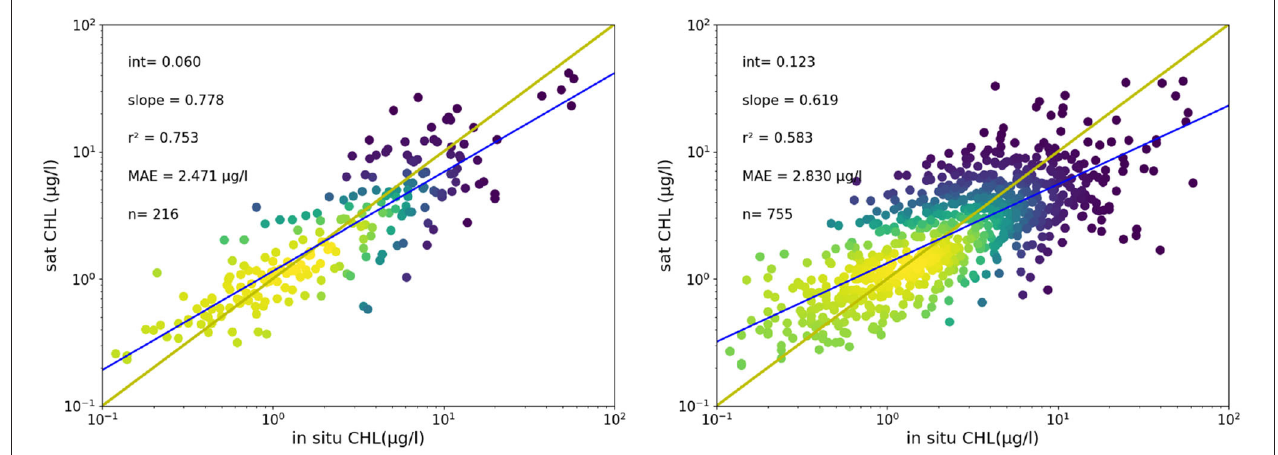
FIGURE 3 | Scatterplots of in situ and satellite CHL observations for the Netherlands using the JMP-EUNOSAT CHL archive, without (left) and with DINEOF interpolation (right) . The relationship between both data sets are described by the Mean Absolute Difference (MAD), Mean Absolute Percentage Error (MAPD). The determination coefficient ( r 2 ) and the slope characterizes the regression (adapted from Van der Zande et al., 2019b).